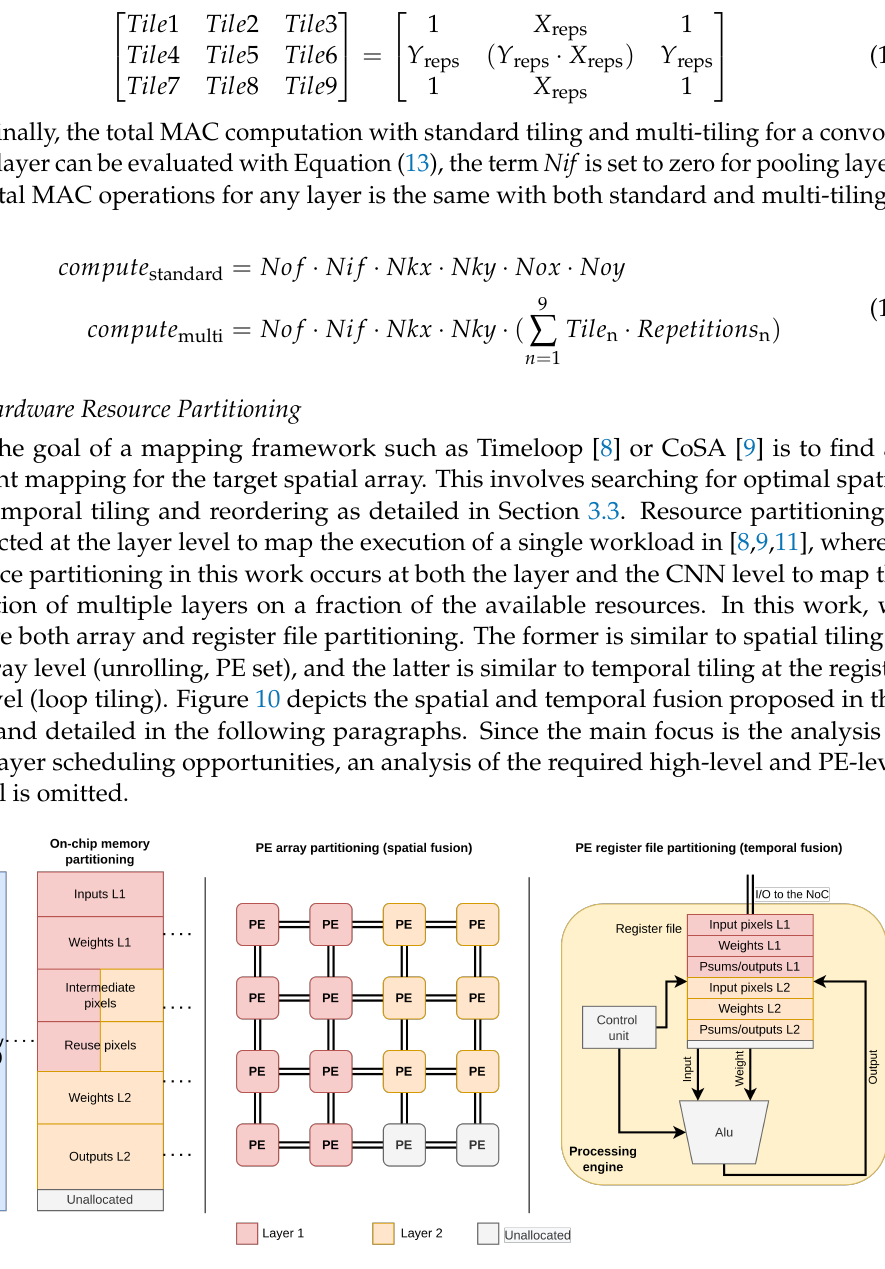
Figure 10. Resource partitioning is applied to the on-chip buffer, the PE array for spatial fusion, and the PE register file for temporal fusion. A hypothetical 2-layer fusion mapping is depicted, showing unallocated memory and array regions. With both single- and inter-layer scheduling, it is possible to have reduced resource utilization due to spatial/temporal tiling factors that are not divisors of the dimensions of the array or the memory. PEs partitioned with either spatial or temporal policies use the on-chip memory to communicate with other PEs assigned to the processing of other